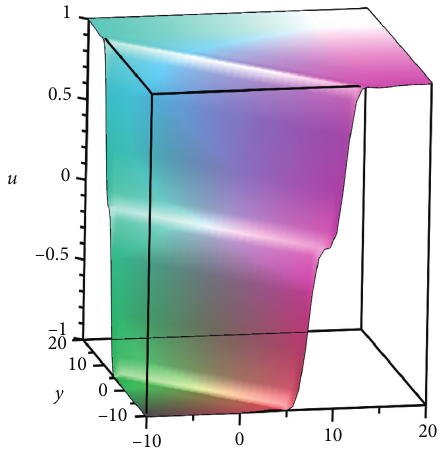
Figure 4: Spatiotemporal structure of solution (23) with parameter selections: a